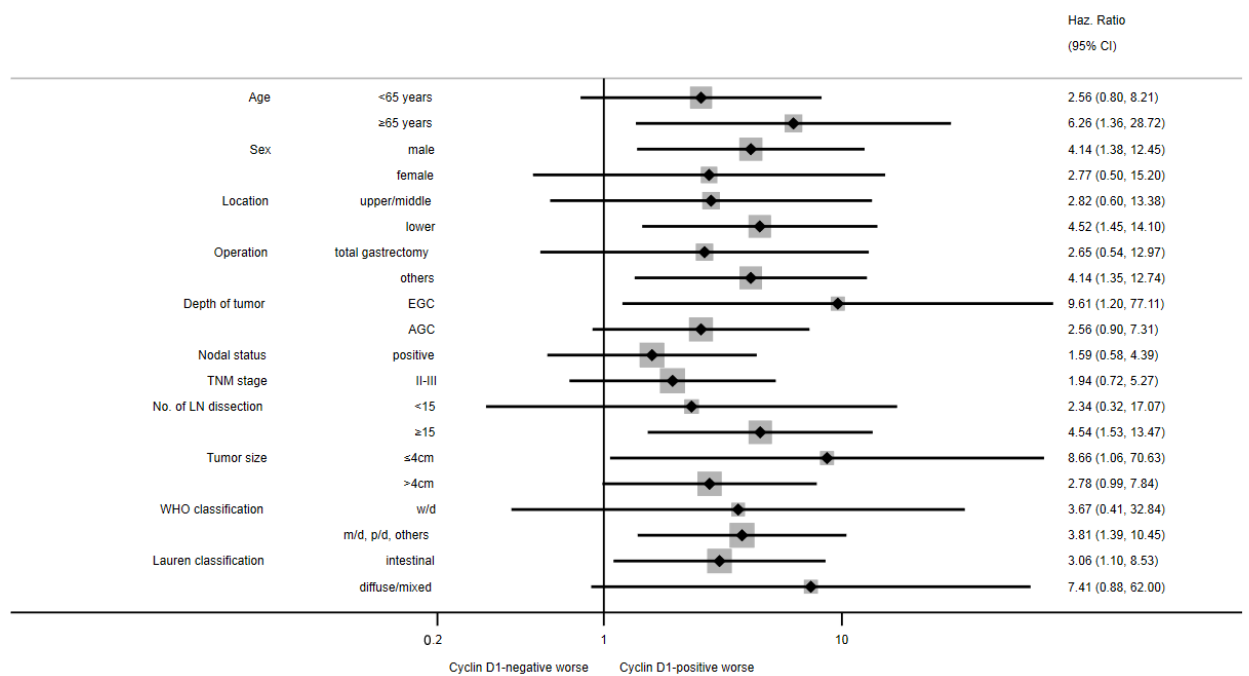
Figure 6. Overall survival by cyclin D1 in ( A ) EGC, ( B ) stage I gastric cancer, ( C ) AGC, and ( D ) stage II-III gastric cancer in propensity score-matched cohort. EGC: early gastric cancer; AGC: advanced gastric cancer.